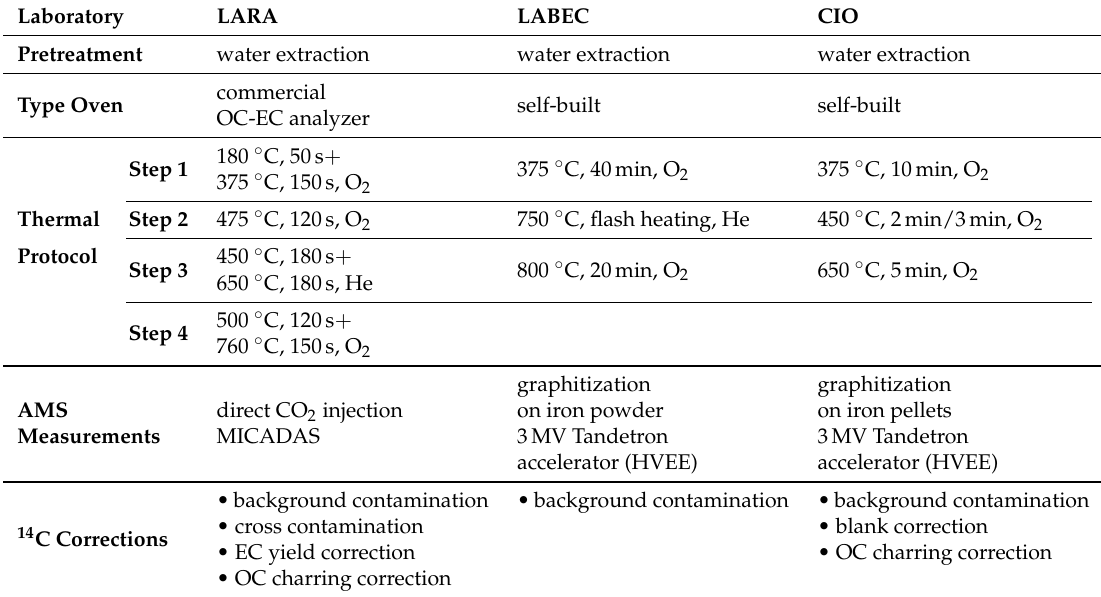
Table 2. Main characteristics of sample treatment for radiocarbon analysis of elemental carbon from the laboratories, which took part in the inter-comparison